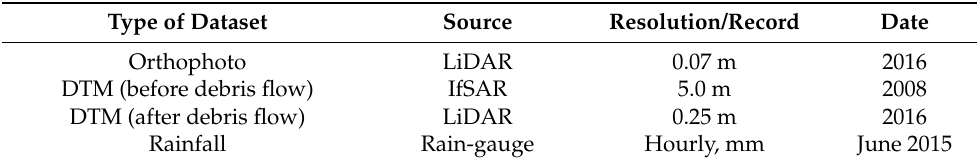
Table 2. The types of datasets used for this study.